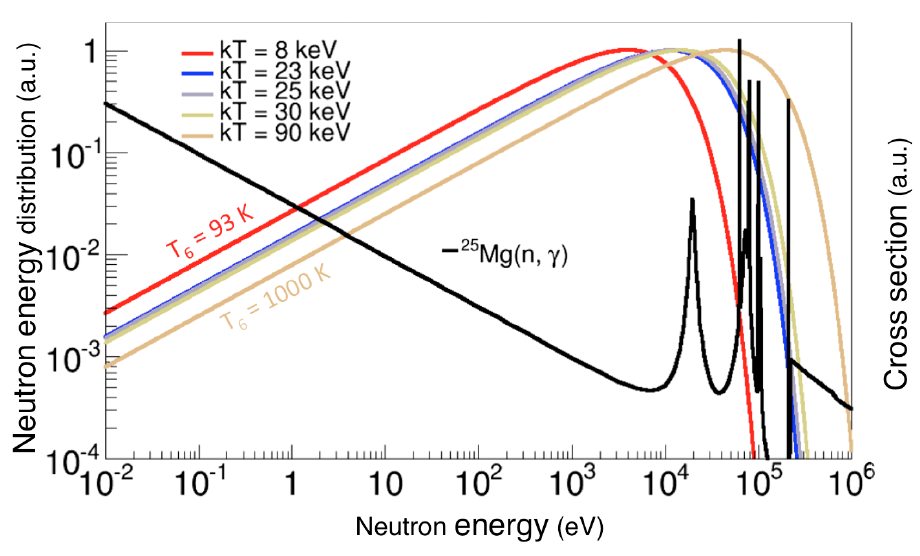
Figure 1. Example of energy distributions of neutrons in stellar interiors for di ff erent temperatures (colored curves), together with a (n, γ ) cross section (black curve). For the sake of representation, y − scales are arbitrarily